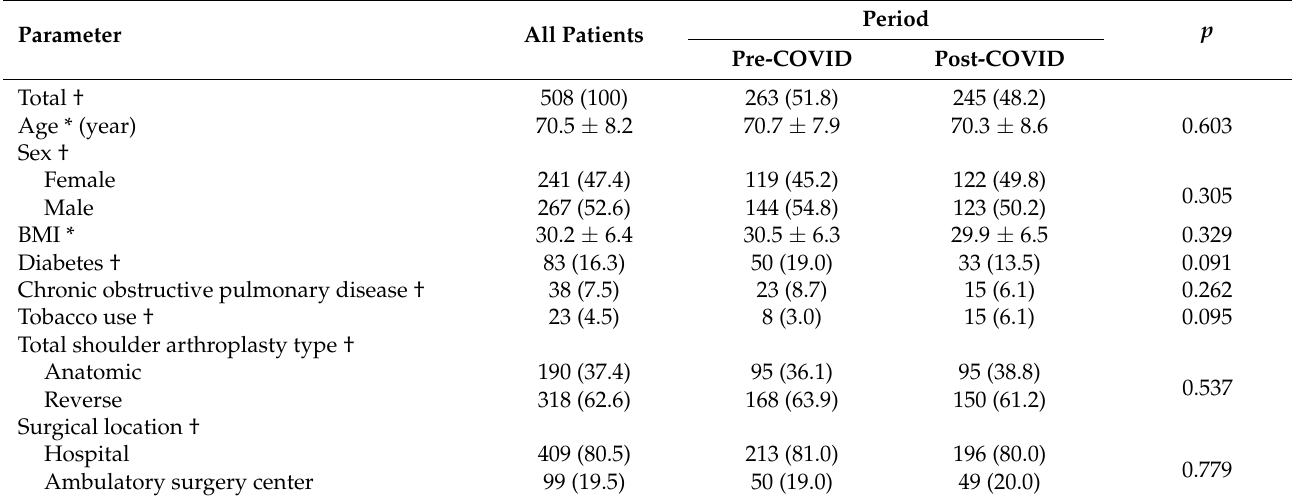
Table 1. Characteristics of the study population.